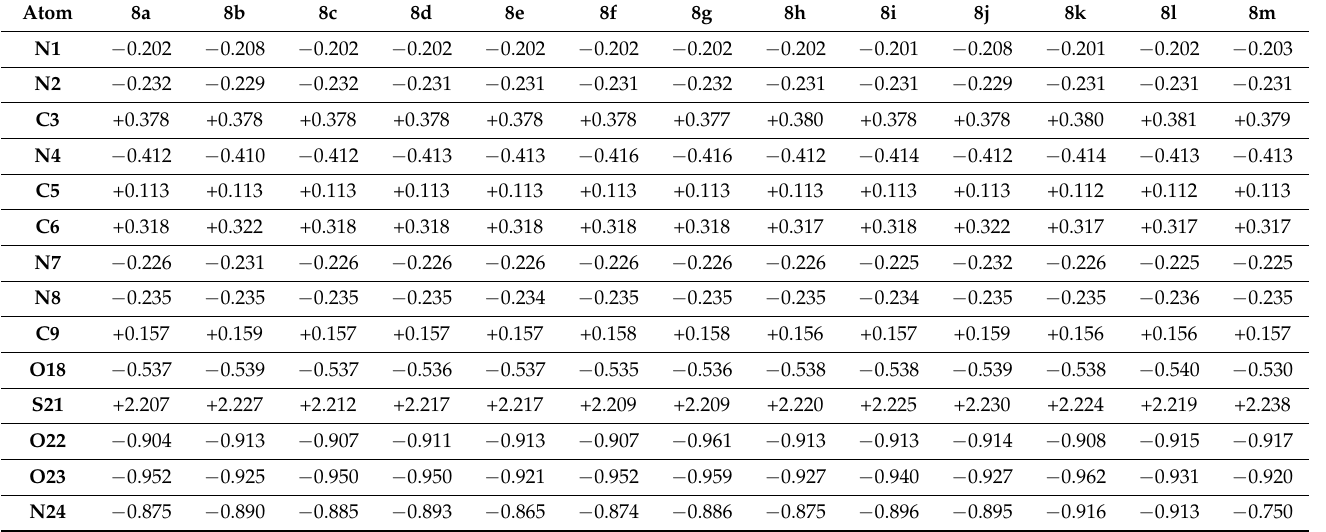
Figure 3. Graphical representation of the HOMO and LUMO orbitals for 8a and 8j , as calculated using the DFT/B3LYP/6-311++G(d,p) method. Table 3. Net atomic charges ( e ) on the selected atoms in the pyrazolo[4,3- e ][1,2,4]triazine-ethoxybenzene-sulfonamide part of molecules 8a – m , calculated using the NBO method at the DFT/B3LYP/6-311++G(d,p)